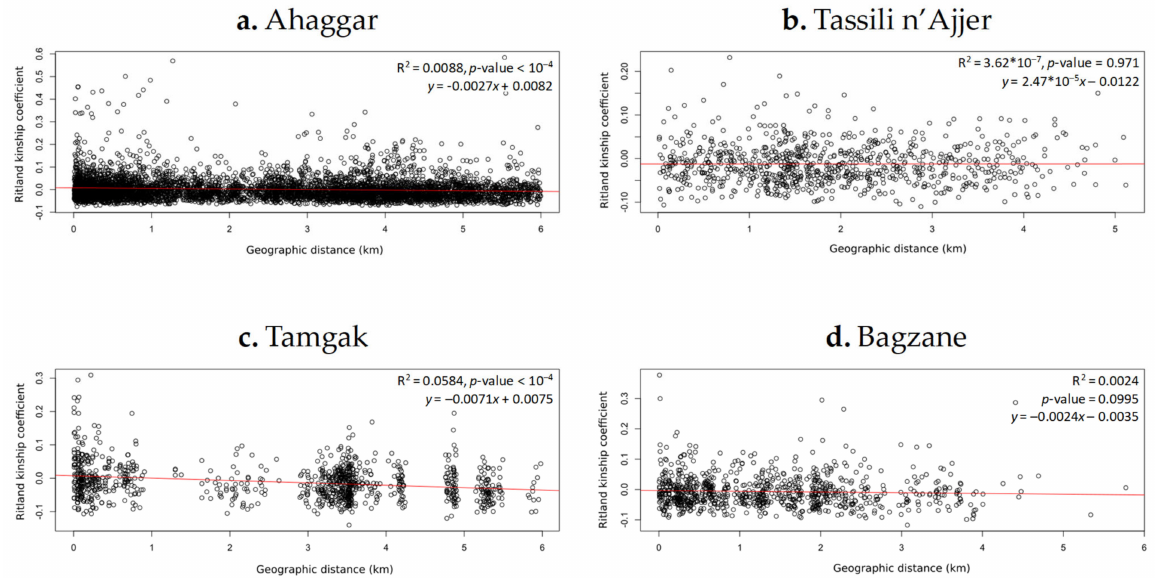
Figure 5. Comparison of Ritland pairwise kinship relationships [59] according to geographic distance in four Saharan massifs on a 6-km scale: ( a ) Ahaggar, ( b ) Tassili n’Ajjer, ( c ) Tamgak, and ( d ) Bagzane. The R-square and p -value statistics are given in the upper right. Each point represents a kinship estimate on a pair of